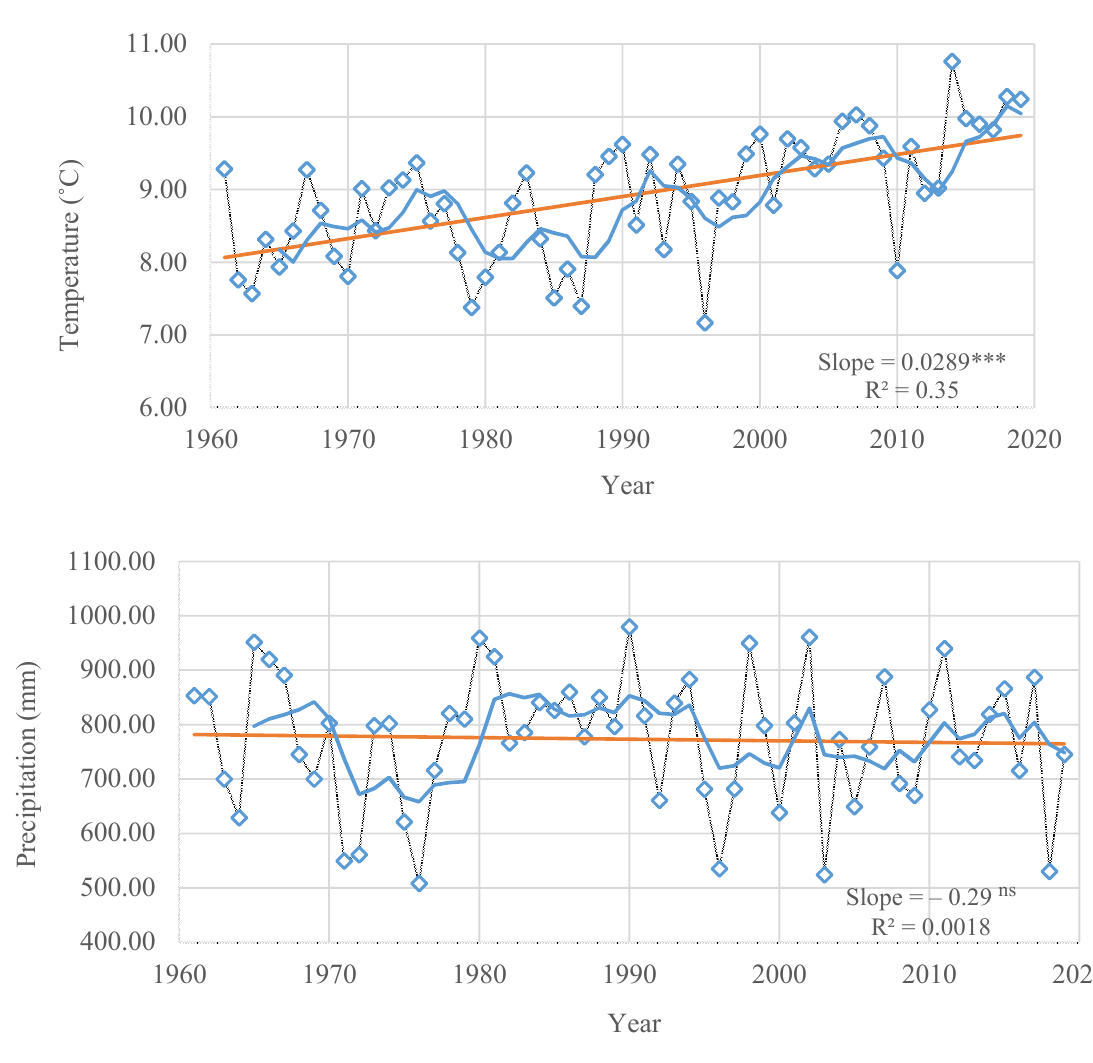
Figure 4. Time series of annual mean daily temperature and precipitation for the selected synoptic station (Kiel-Holtenau, 1961–2019). The solid red line shows a regression analysis, and the blue line denotes the 5 year moving average. Linear regression analyses test shows a significant trend (*** p <0.001) in annual temperature. ns = not significant.